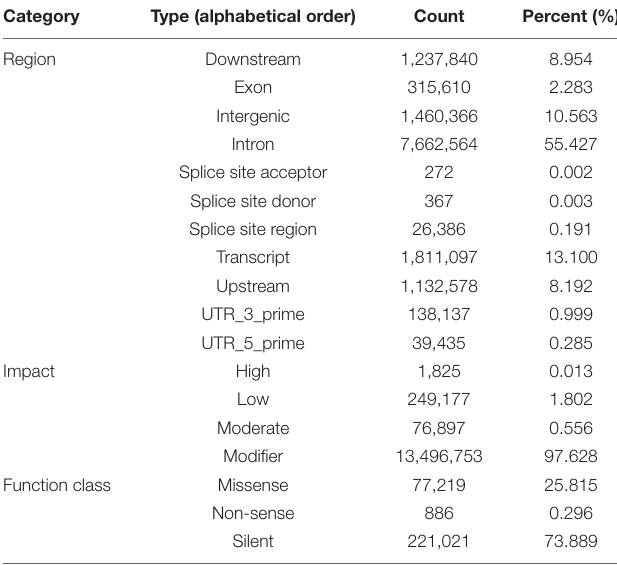
TABLE 1 | SNP annotation by genomic region, impact and function